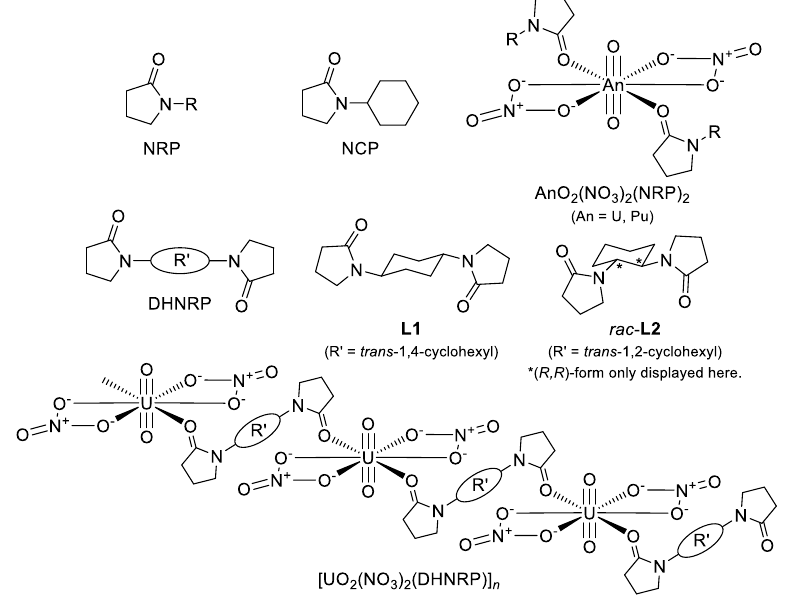
Figure 1. Schematic structures of NRPs, DHNRPs, and their actinyl(VI) nitrate complexes.